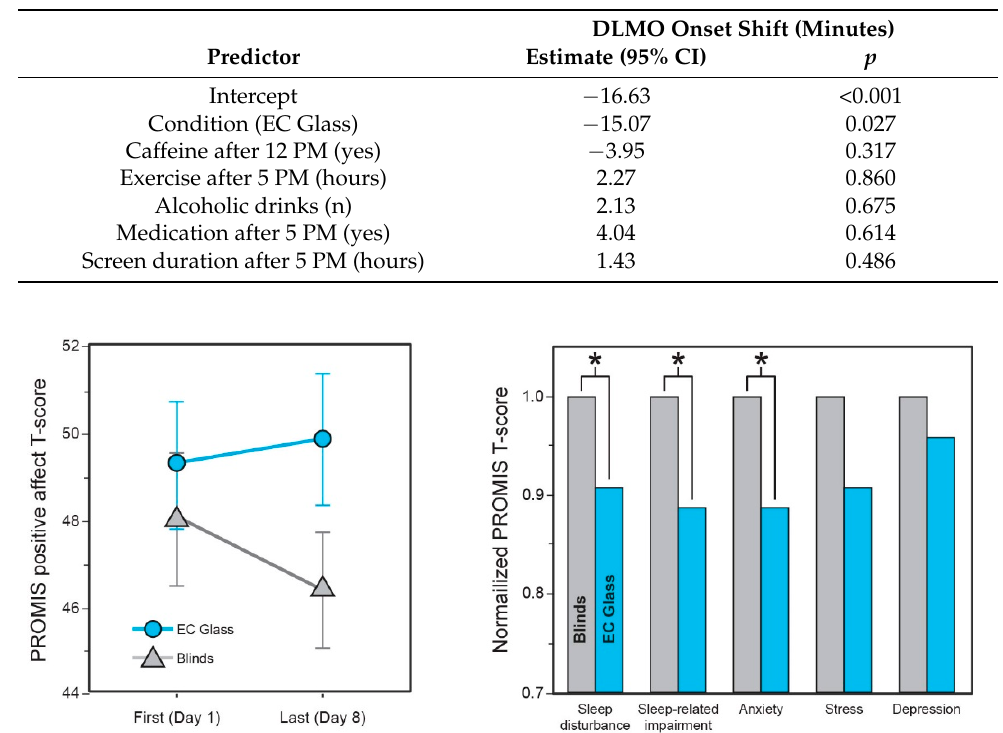
Table 5. Results of the linear mixed-effects model of condition and dim light melatonin onset.